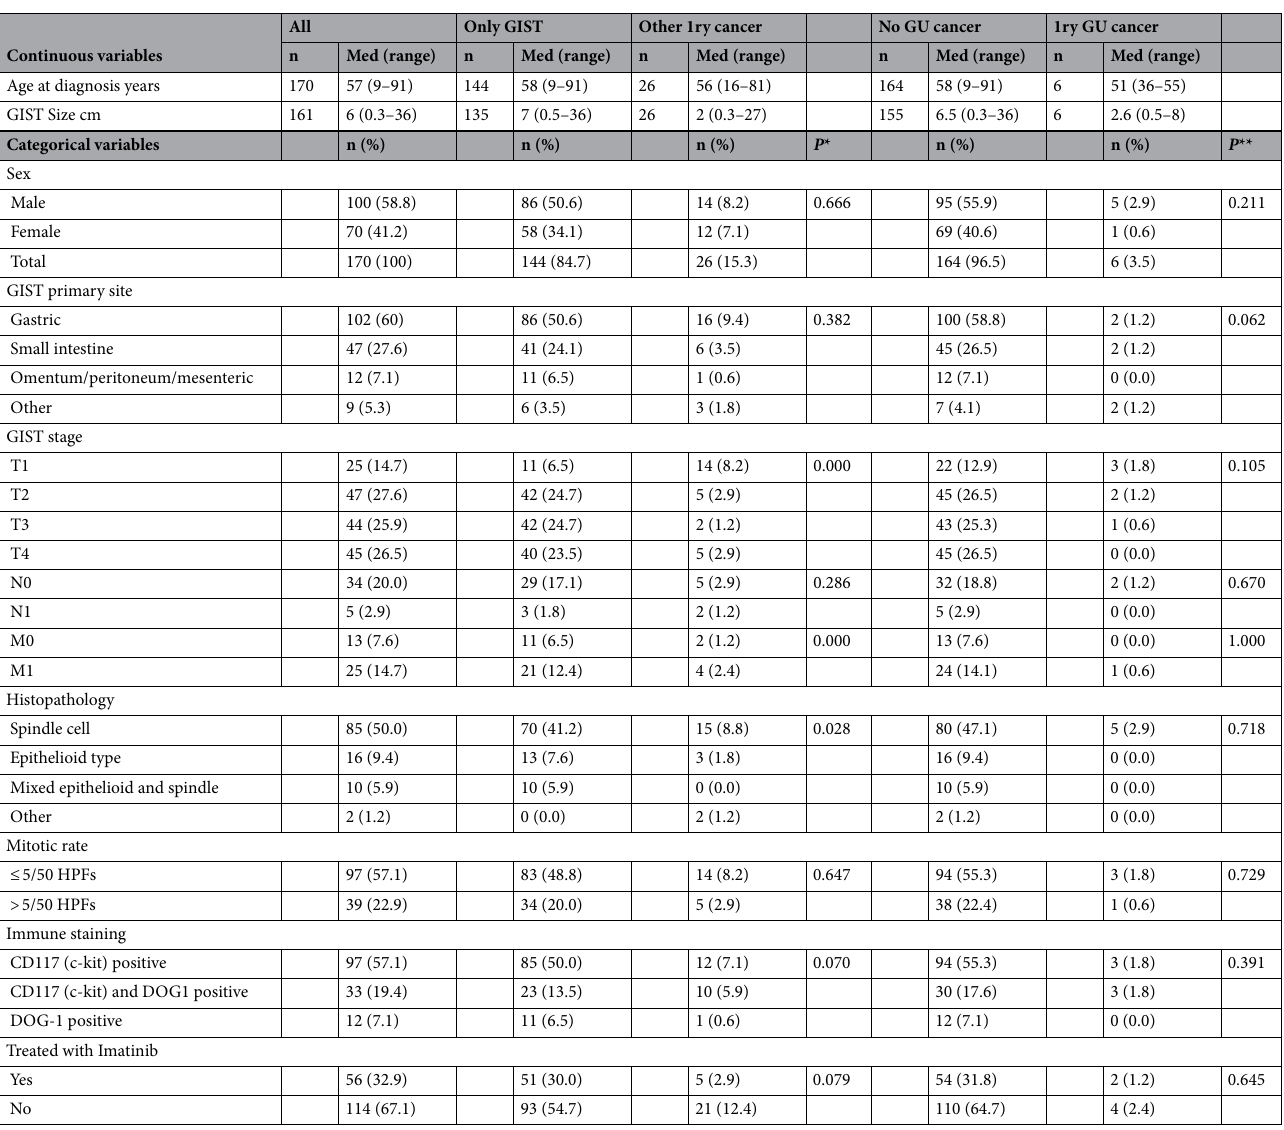
Table 1. Demographic and pathological characteristics of patients with GIST and associated cancer. GIST gastrointestinal tumor; GU genitourinary; HPF high power field; Med median; P Fisher’s Exact Test 2-tail; P* comparison only GIST vs other primary cancer; P** comparison GU cancer vs no GU